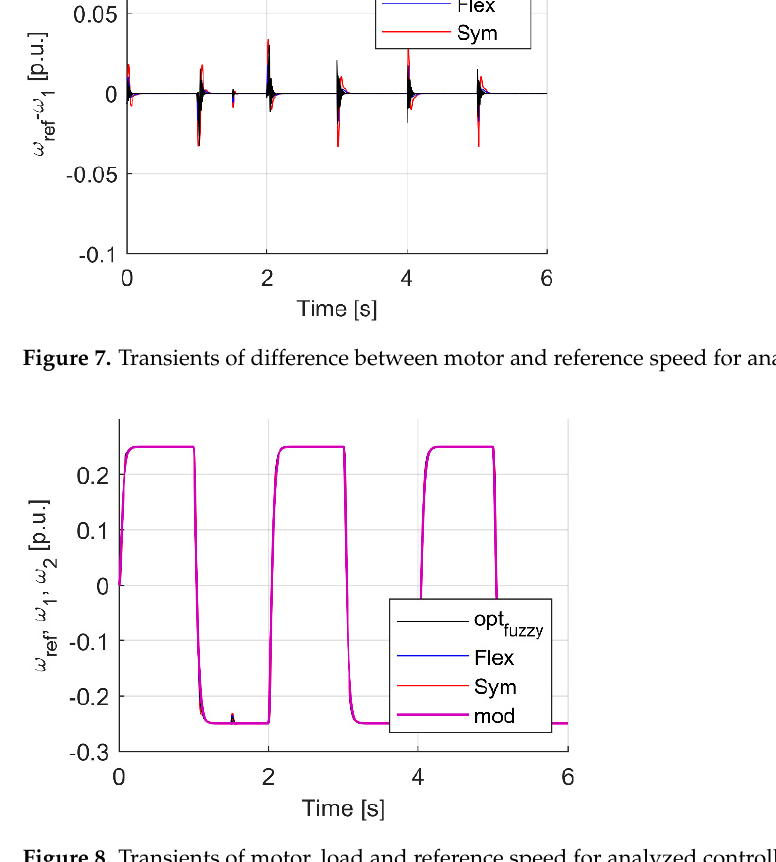
Figure 8. Transients of motor, load and reference speed for analyzed controller cases.